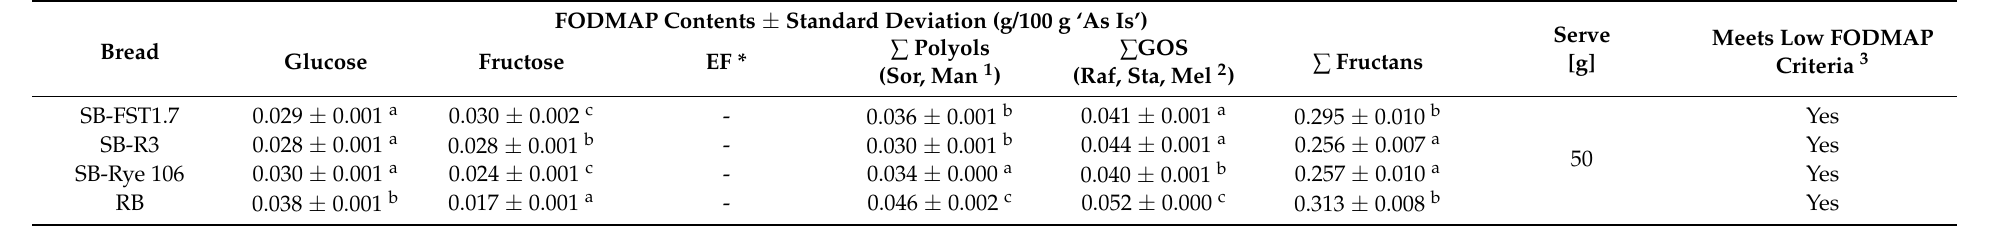
Table 4. FODMAP concentrations (g/100 g ‘as is’) in RB, produced with commercial baker’s yeast preparation (2%; Puratos, Belgium) and with baker’s